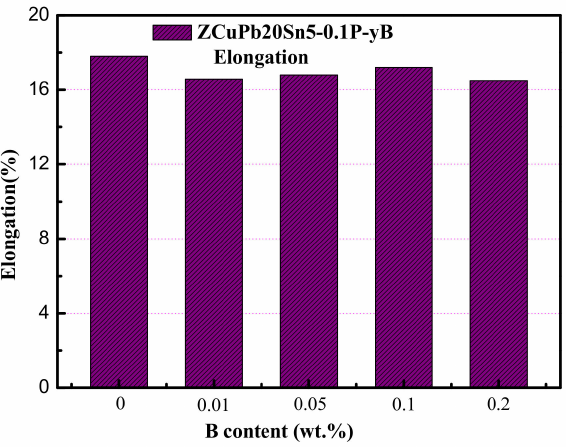
Figure 13. Elongation of ZCuPb20Sn5 alloy with different B element